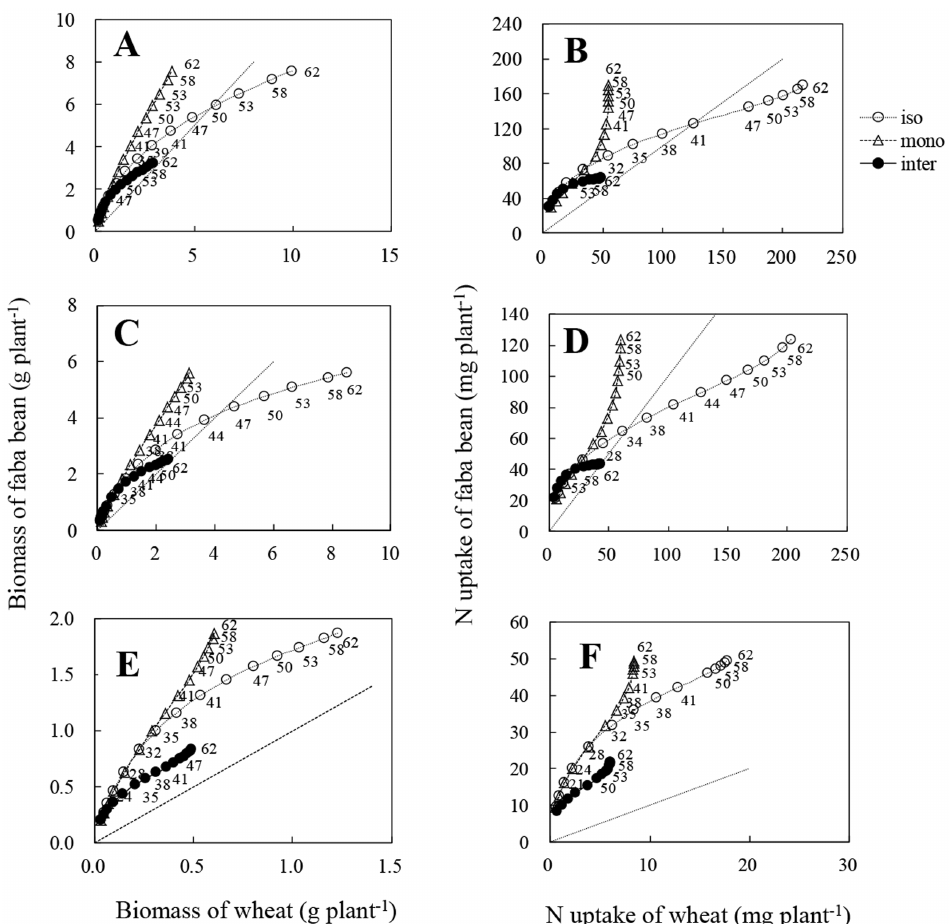
Fig. 5. Trajectories of cumulative biomass production and cumulative nitrogen (N) uptake of total (A, B), shoot (C, D) and root (E, F) by isolated (iso: open circle and dashed curve), monocropped (mono: open triangles and dashed curve), intercropped (inter: solid symbols and continuous curve) wheat and according faba bean. Data was derived from the logistic equation using the mean of actual data at each sampling. Numbers near the curves represent the samplings time (day). The dashed line shows the 1:1 relationship between faba bean and wheat.